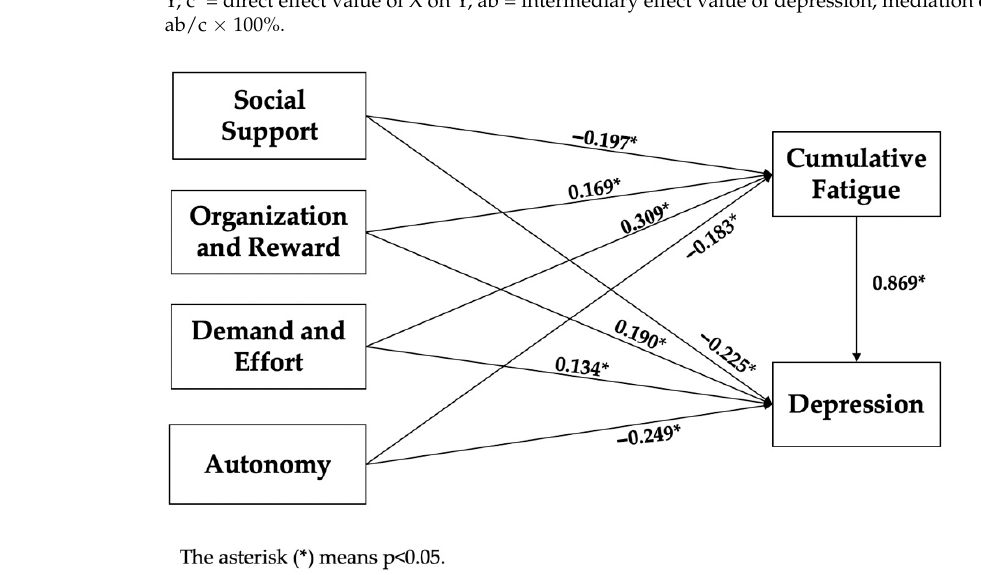
Figure 2. The mediating model of cumulative fatigue between occupational stress and depressive symptoms. Table 7. Analysis of the mediating effect of cumulative fatigue between occupational stress and depressive